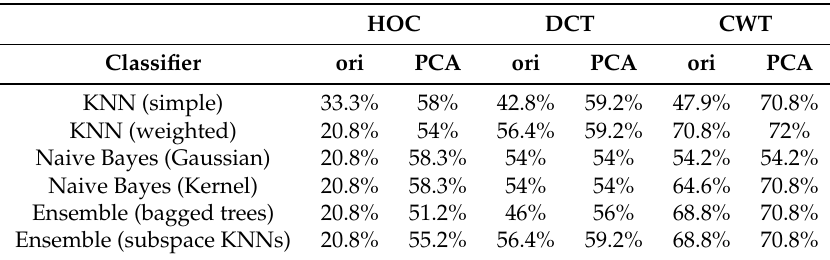
Table 1. Classification accuracy for the classification of damages of diameters 500 µ m and 600 µ m without using principal component analysis (PCA)-based dimensionality reduction (ori) and with using PCA-based dimensionality reduction. KNN = k-nearest neighbor; HOC = higher order crossings; DCT = discrete cosine transform.